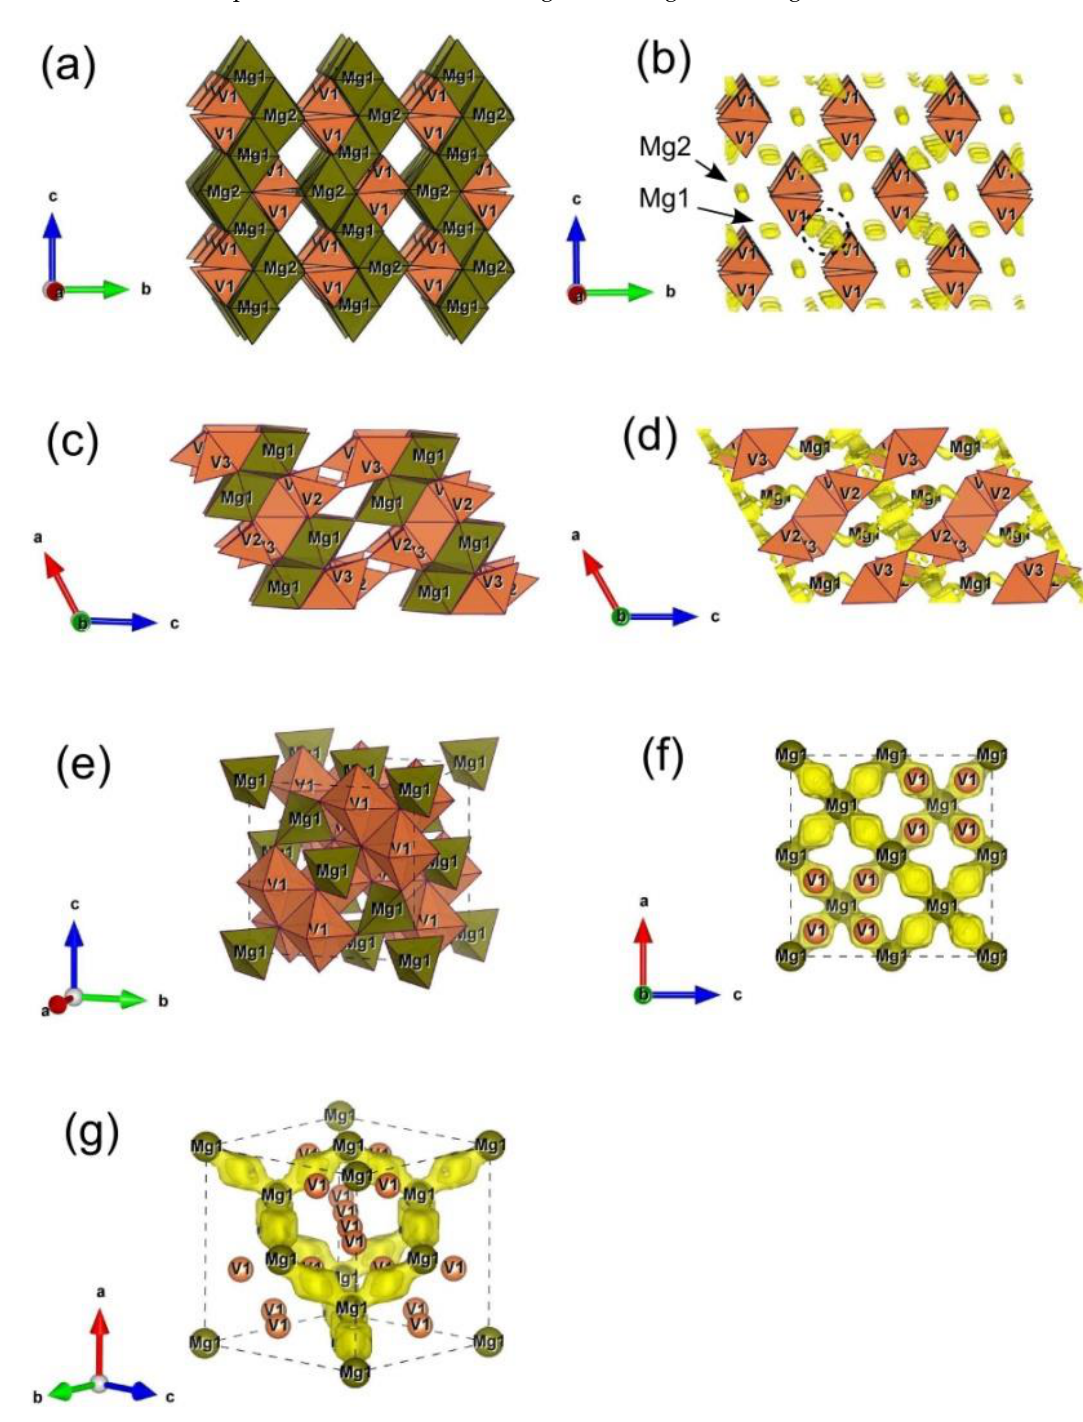
Figure 11. Models of migration pathways for Mg 2+ ion obtained by BVS analysis of vanadate phase constituents of MgVO/C. Polyhedral representation of Mg 3 V 2 O 8 ( a ) and BVS map within its structure ( b ); polyhedral representation of β -MgV 3 O 8 ( c ) and BVS map within its structure ( d ); polyhedral representation of MgV 2 O 4 ( e ) and BVS map within its structure viewed from different directions ( f , g ). BVS volumes are defined by ±0.1 v.u. mismatch from the valence +2 of Mg. In the second investigated structure, which is beta phase MgV 3 O 8 , magnesium occupies an octahedral position with symmetry: 1 (denoted as Mg1), which it randomly shares with one V 4+ ion; edge- and corner-shared Mg1O 6 octahedrons thus form layers